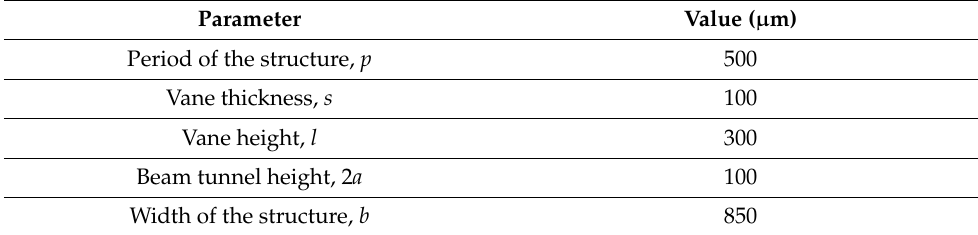
Figure 3. Schematic of the DSG SWS unit cell. Table 1. Dimensions of the DSG SWS.